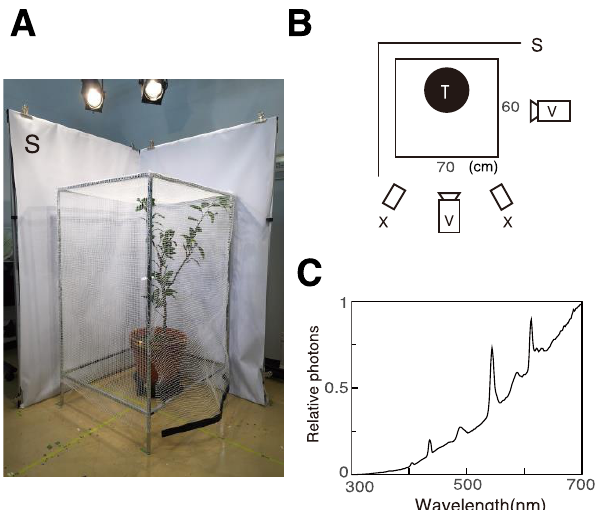
Figure 1. Experimental setup. ( A ) Photograph of the setup with a small cage. ( B ) Top view of the setup. ( C ) Irradiation spectrum of illumination. S: Screen, V: video camera, X: Solar lamp.